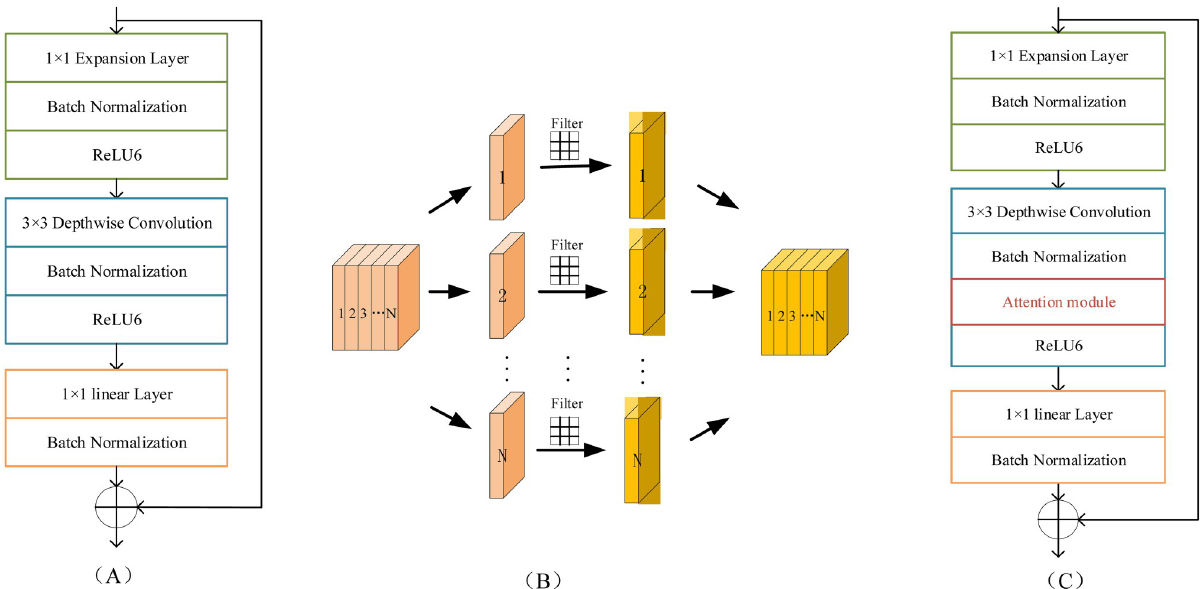
Fig 1. The original Bottleneck module and the improved Bottleneck module. A: original Bottleneck module. B:depthwise convolution. C: improved Bottleneck